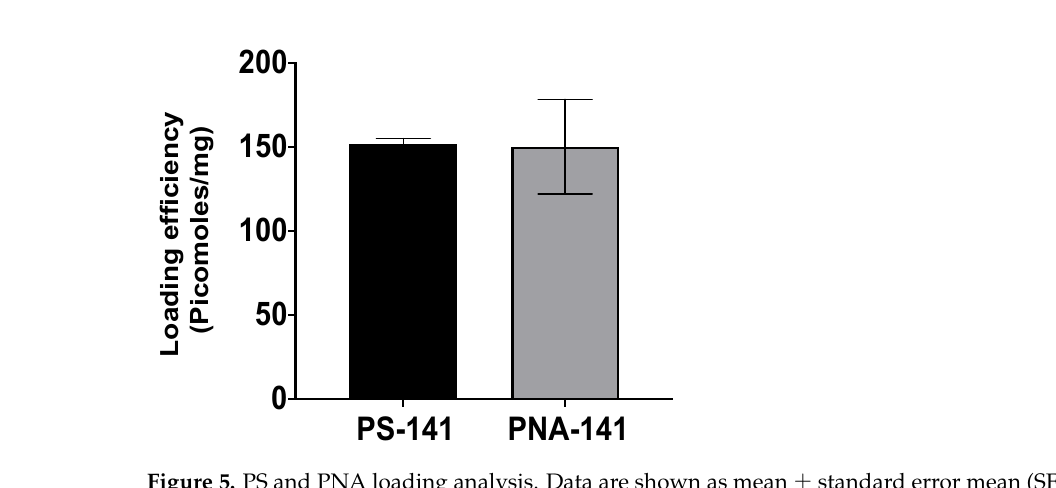
Figure 4. Cumulative release profile data of ( A ) PS and ( B ) PNA antimiR-141 and scramble oligo- mers from PLGA NPs at indicated time points (shown on the X-axis) in a graph. Data are shown as mean ± standard error mean (SEM).